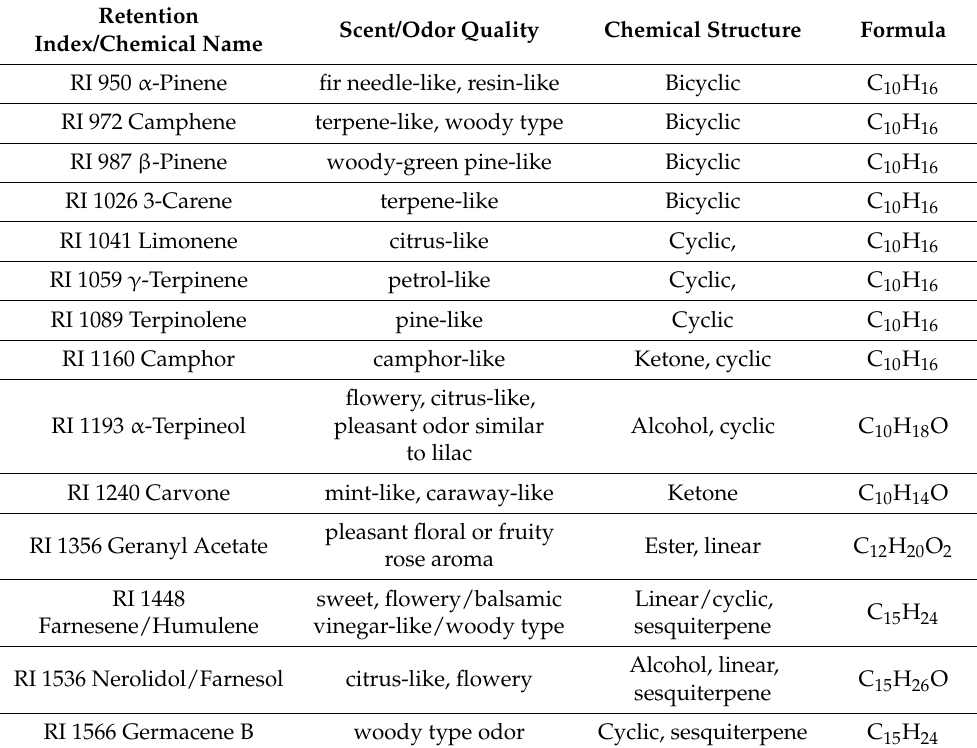
Table A2. Some basic information on scent and chemical structure of terpene/terpenoid compounds identified/present in the studied forest